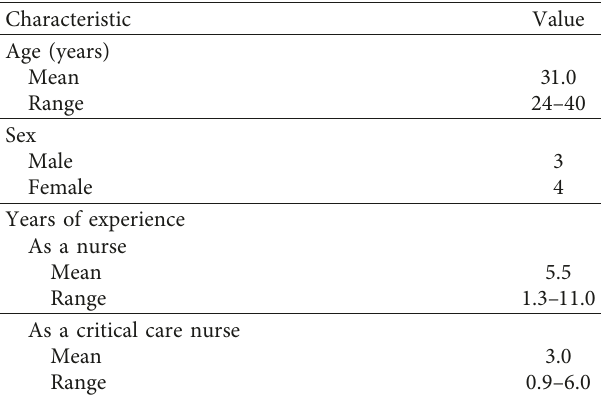
Table 2: Characteristics of nurses ( n �